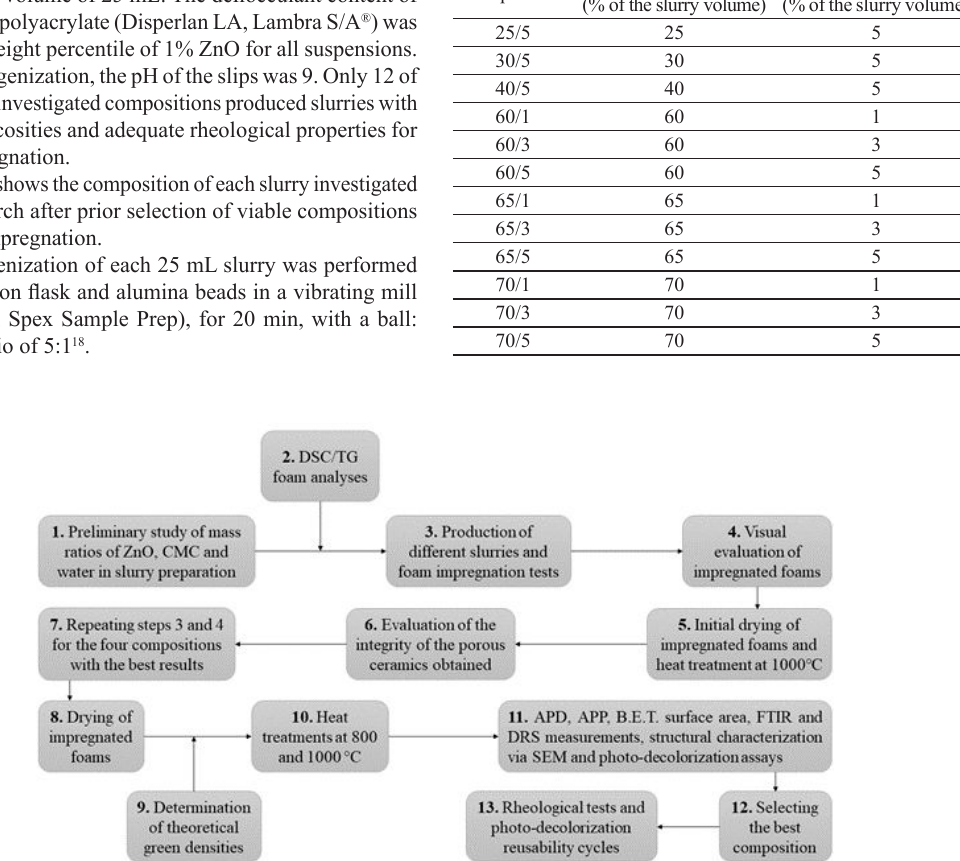
Table 1. Slurries compositions after a prior selection of viable compositions for foam impregnation.